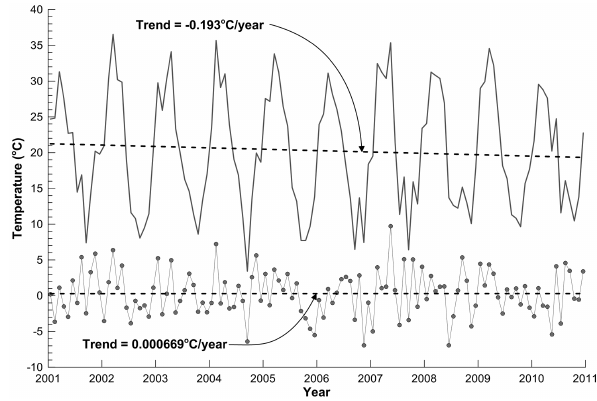
Figure 1. Solid grey line: a synthetic time series created from a purely periodic signal (plus noise) but still exhibiting a non-zero trend (upper dashed straight line fit). Line with filled dots: the de- seasonalized signal with a straight line fit showing no statistically significant